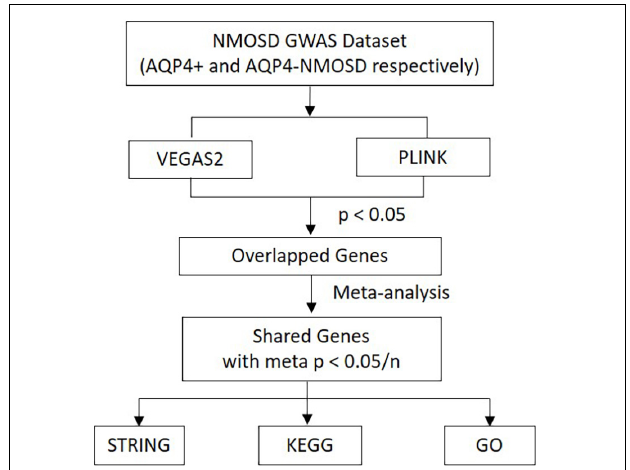
FIGURE 1 | Flow diagram of the three-phase analysis design. In phase I, two new gene-based tests for the GWAS approach, called VEGAS2 and PLINK, were used to conduct a gene-based association study. In phase II, Gene sets identified with meta p < 0.05/n were carried forward to the next phase. In phase III, protein-protein association networks were performed by STRING. Meanwhile, KEGG pathways and GO analysis were carried out for these NMOSD susceptibility genes. VEGAS2 and PLINK are two kinds of new gene-based tests. “n” represents the number of genes shared by the VEGAS2 and PLINK